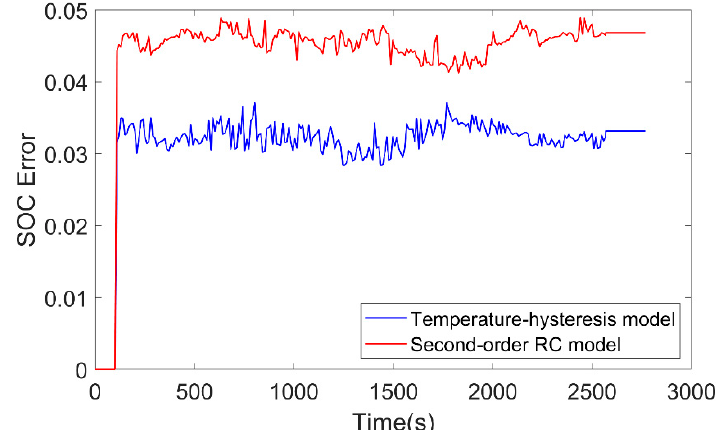
Figure 21. SOC estimation error under variable temperature conditions.